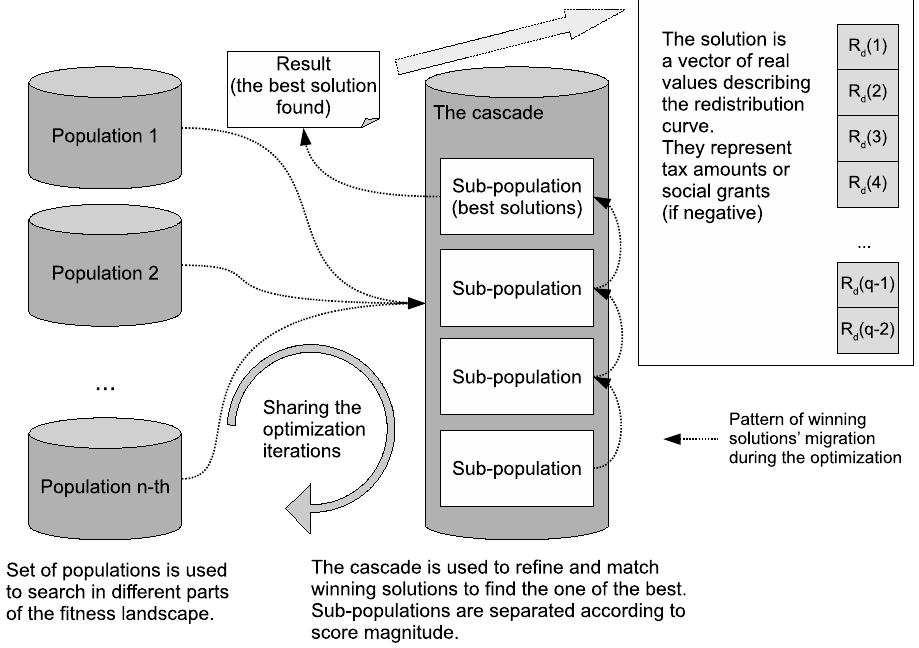
Figure 8. Iterations sharing between populations managed by the algorithm during the optimization and migration paths of the